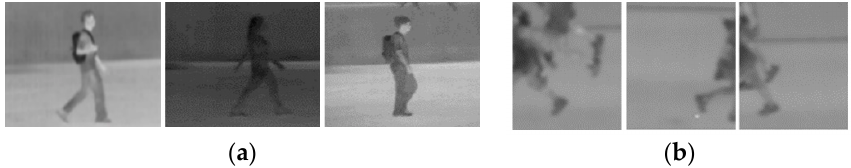
Figure 17. Example images of datasets in fold-1. ( a ) Example images used in training phase; ( b ) example images used in testing phase.